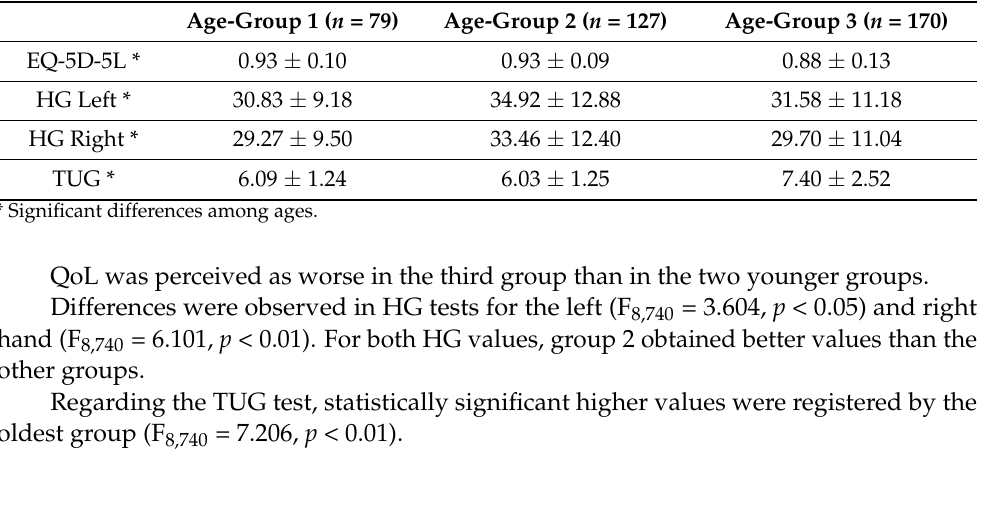
Table 2. Mean ± SD values of health perception (EQ-5D-5L), left (HG Left) and right (HG Right) grip strength, and the Timed Up and Go test (TUG) based on age